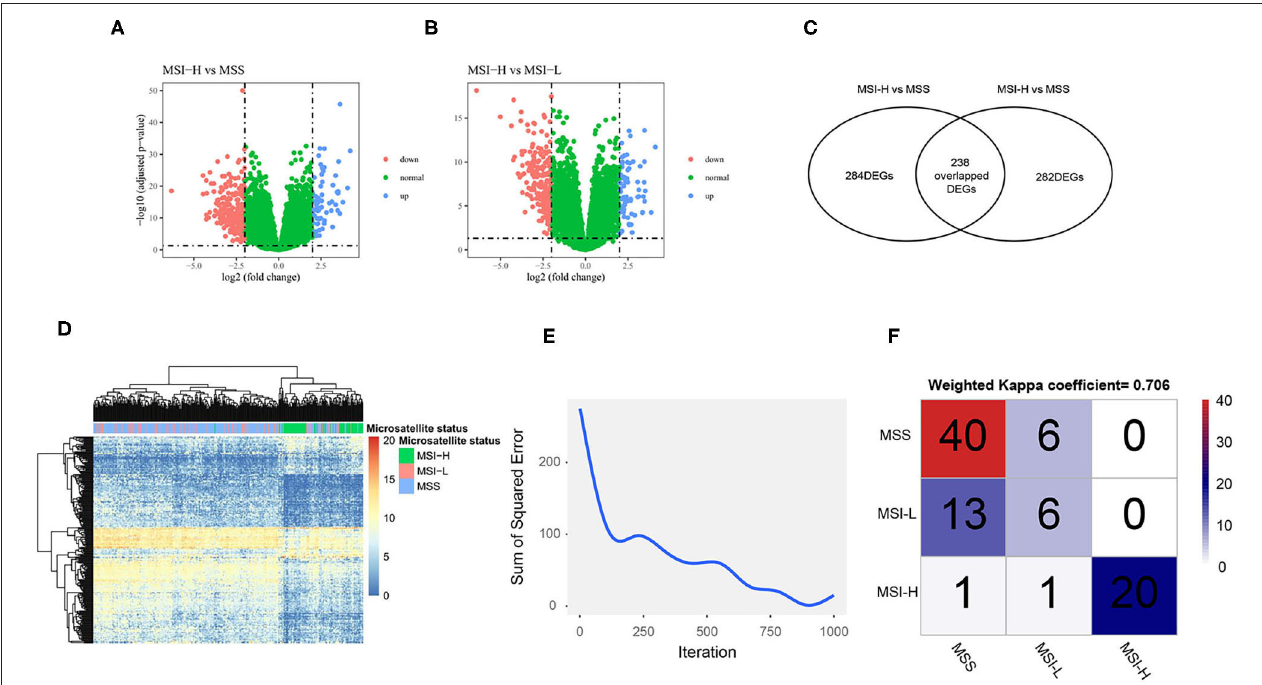
FIGURE 4 | The differentially expressed genes (DEGs) analysis and neural network construction. Volcano plot shows the DEGs of MSI-H vs. MSS (A) and MSI-H vs. MSI-L (B) ; Venn plot shows that 284 DEGs were found between MSI-H and MSS and 282 DEGs were found between MSI-H and MSI-L (C) . A total of 238 overlapped DEGs were selected as the final DEGs; heatmap of the DEGs (D) shows that the MSI-H samples were clustered differently from the MSS and MSI-L samples. (F) The sum of the squared error decreases as the iteration arises and the confusion matrix (F) shows the performance of the neural network in the test